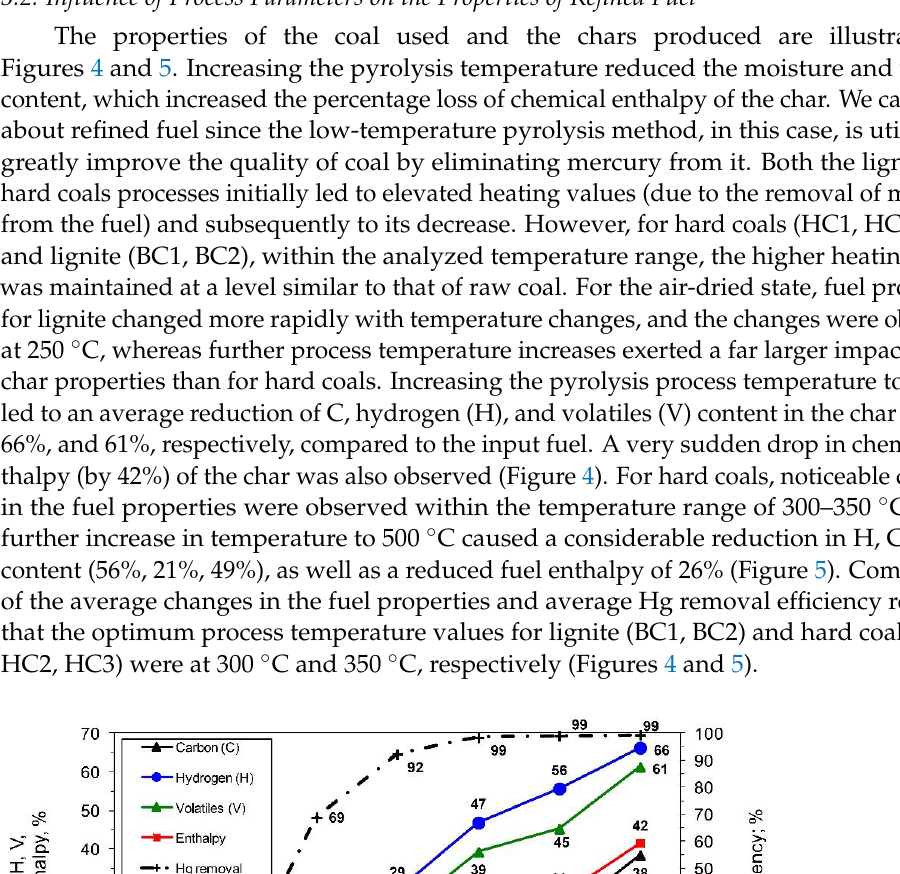
Figure 5. Average change of parameters and composition of refined fuel for hard coals; percentage loss content of C, H, and V, fuel chem. enthalpy vs. process temperature.